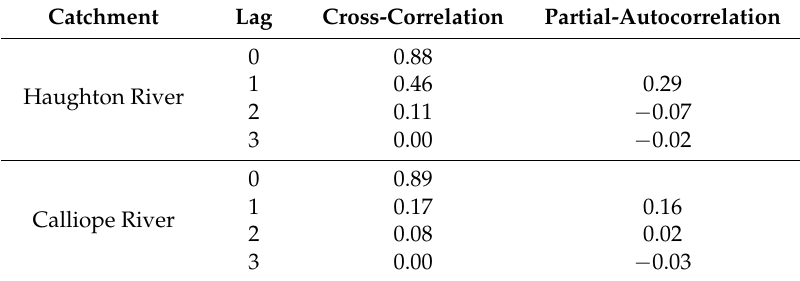
Table 3. Cross correlation between monthly runoff and rainfall data with 5% significance limits and Partial autocorrelation for monthly runoff data with 5% significance limits for Haughton River and Calliope River catchments. Catchment Lag